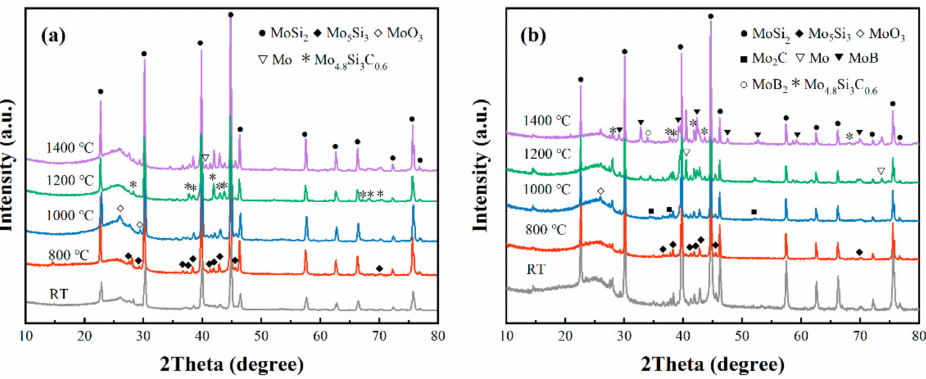
Figure 6. XRD patterns of the residue phases of BP-0 ( a ) and BP-15 ( b ) at different